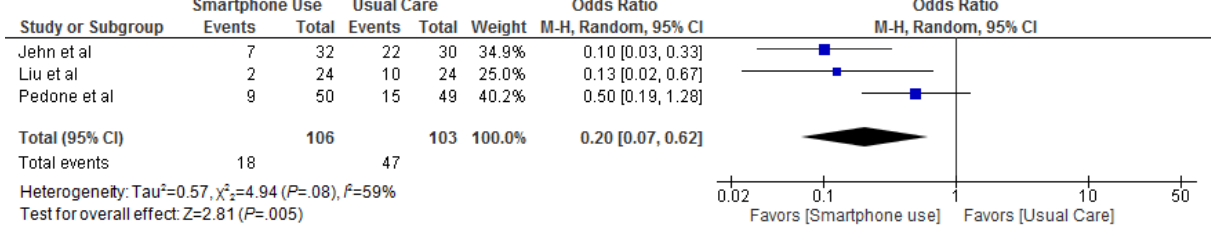
Figure 2. Effects of smartphone interventions on the number of patients having a COPD exacerbation.COPD: Chronic Obstructive Pulmonary